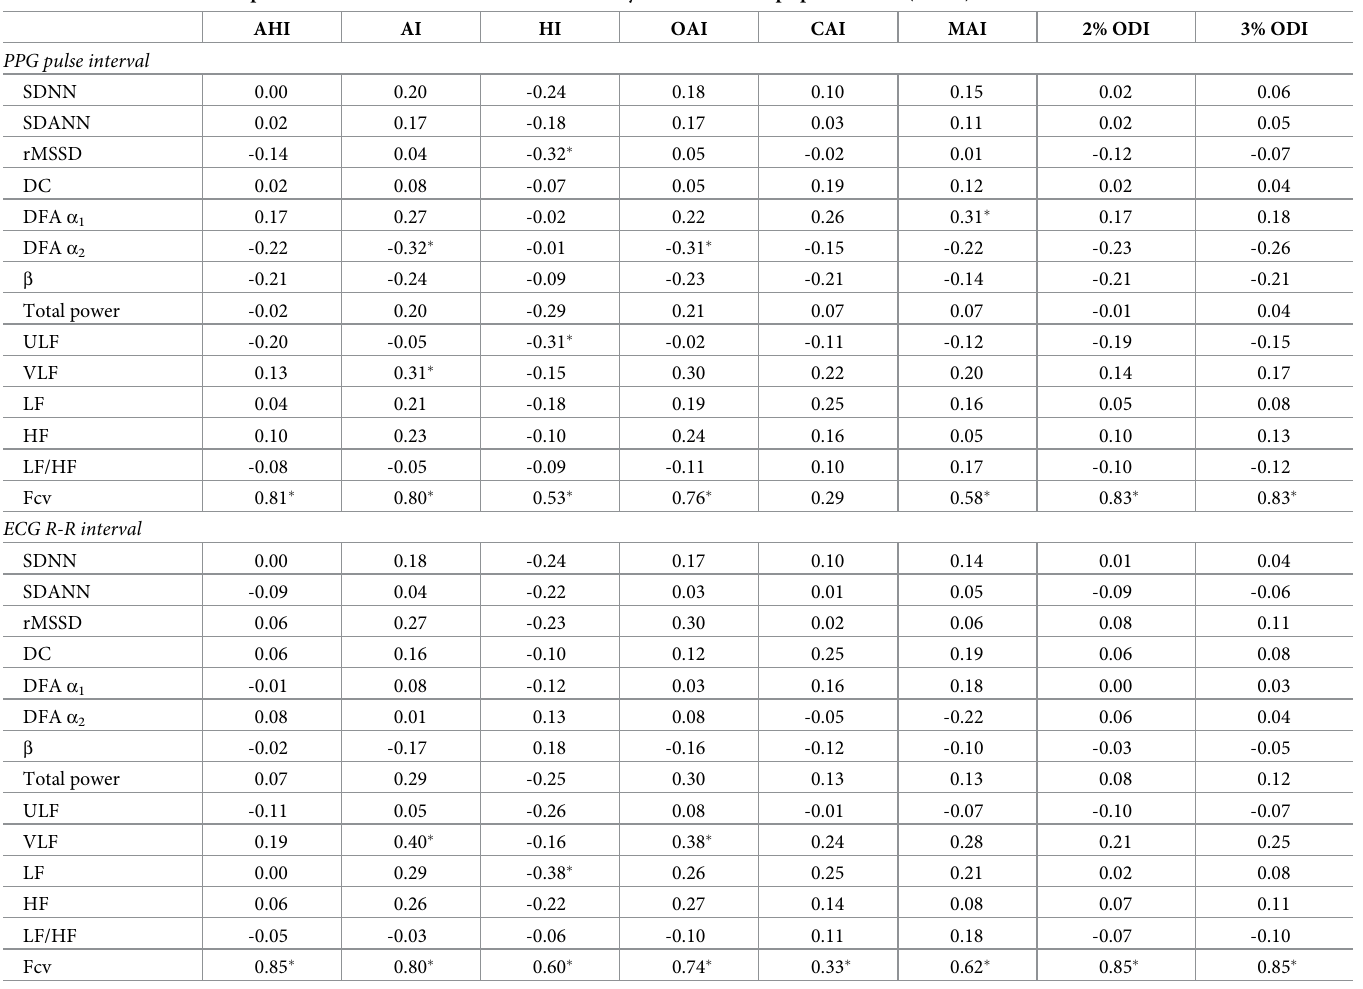
Table 3. Correlations of PPG pulse interval and ECG R-R interval variability indices with sleep apnea indices (n =